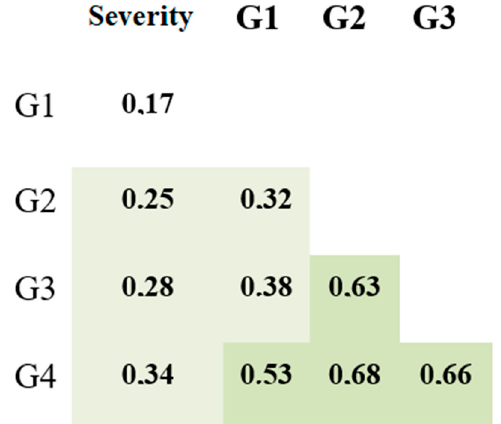
Figure 8. Correlation matrix for anti-S protein IgG subclasses and illness severity, analyzed with Spearman correlation coefficient. Darker shades of green represent more solid correlation: 0.2–0.39—weak correlation; 0.4–0.69—fair correlation; 0.7–1.0—solid correlation. p -value for all presented coefficients < 0.001.